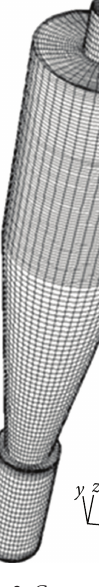
Figure 2: Computational